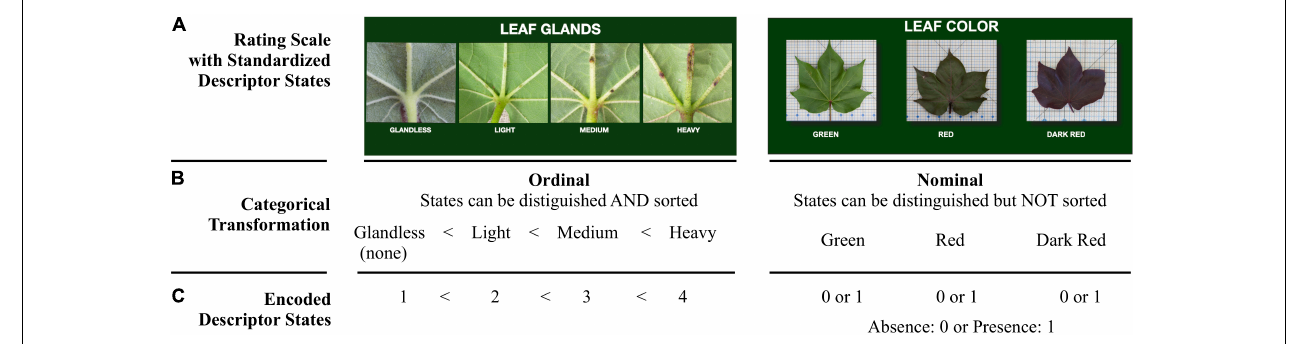
FIGURE 1 | Example of a categorical classification and encoding transformation of phenotypic descriptors. (A) Rating scales showing four (for leaf glands) or three (for leaf color) standardized descriptor states. (B) Examples of classifying two types of descriptor states, ordinal and nominal. (C) Encoding data transformation from text format to integer format prior to applying statistical analysis.